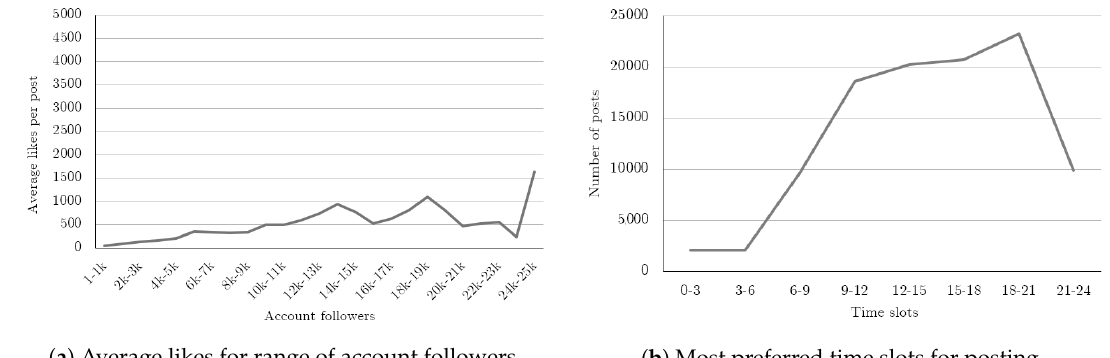
Figure 2. Some information about the Instagram accounts included in our dataset: in ( a ), the average likes for different ranges of account followers is shown; in ( b ), the most preferred times per post publication are